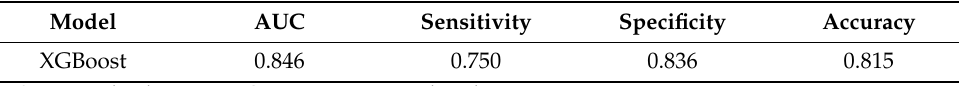
Table 3. Prediction performance for the external validation